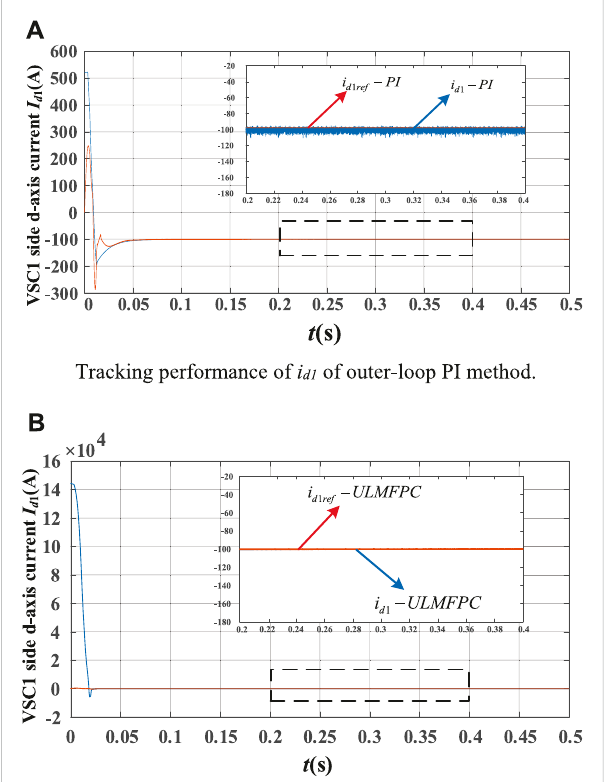
FIGURE 9 (A) Tracking performance of i Tracking performance of i d1 of outer-loop ULMFPC